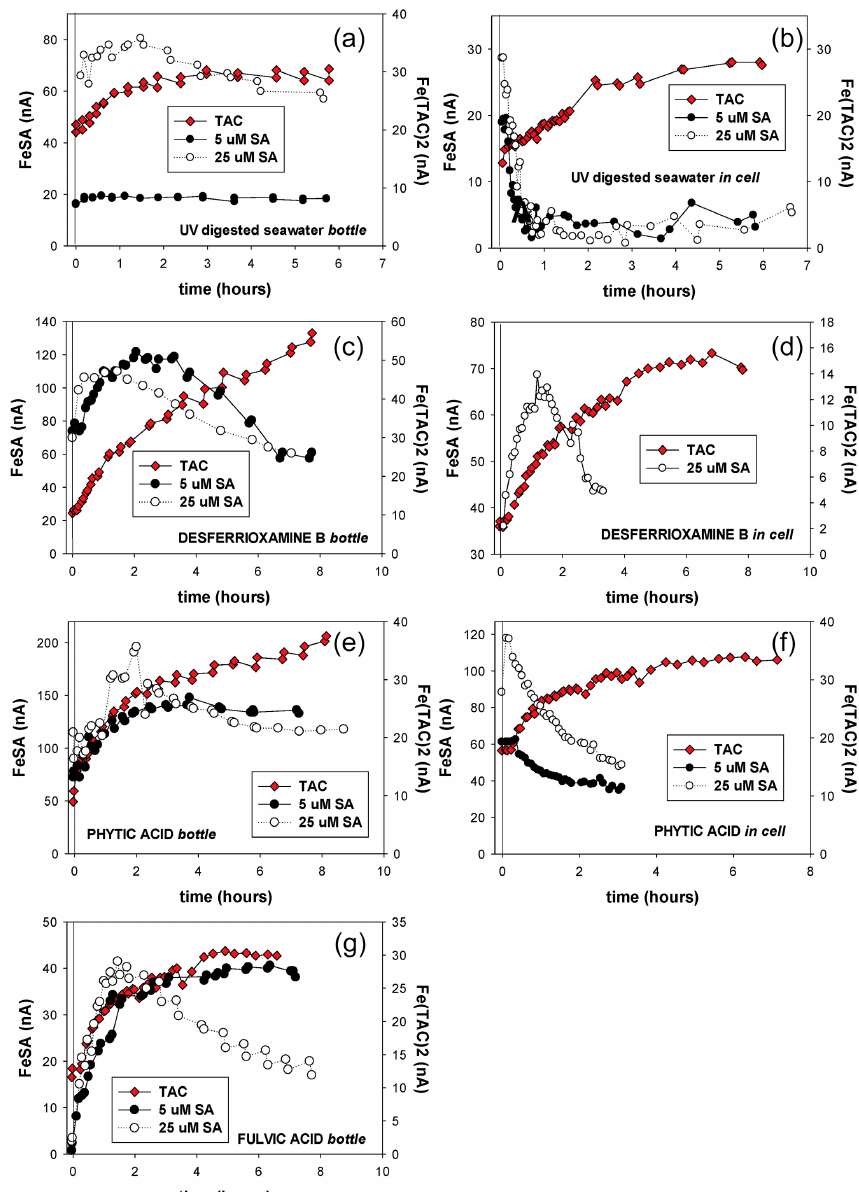
Figure 6. Kinetic measurements for the formation of Fe–SA complexes the change in peak height versus time. At t = 0 the AL is added. In-cell means the whole experiment is done in the same 10mL which was placed in the cell; dispensed mercury accumulates at the bottom of the cell. Bottle experiment means for every measurement a fresh 10mL was taken from a large volume of sample. Here the reaction takes place in the large volume, and AL was added at t = 0. (a, b) UV-irradiated seawater (UV), (c, d) UV + desferrioxamine B , (e, f) UV + phytic acid bottle (a, c, f) and in-cell experiments (b, d, f) are shown. (g) For FA only bottle experiments were done with SA5 and SA25 as AL.